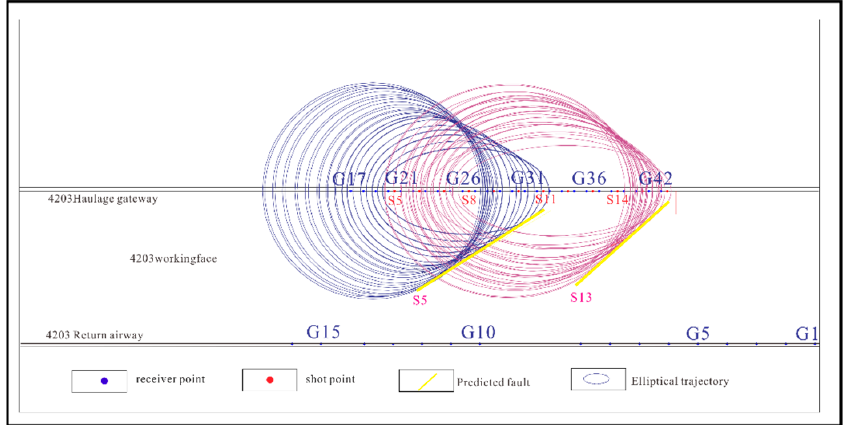
Figure 4. Results of the elliptical tangent offset method.